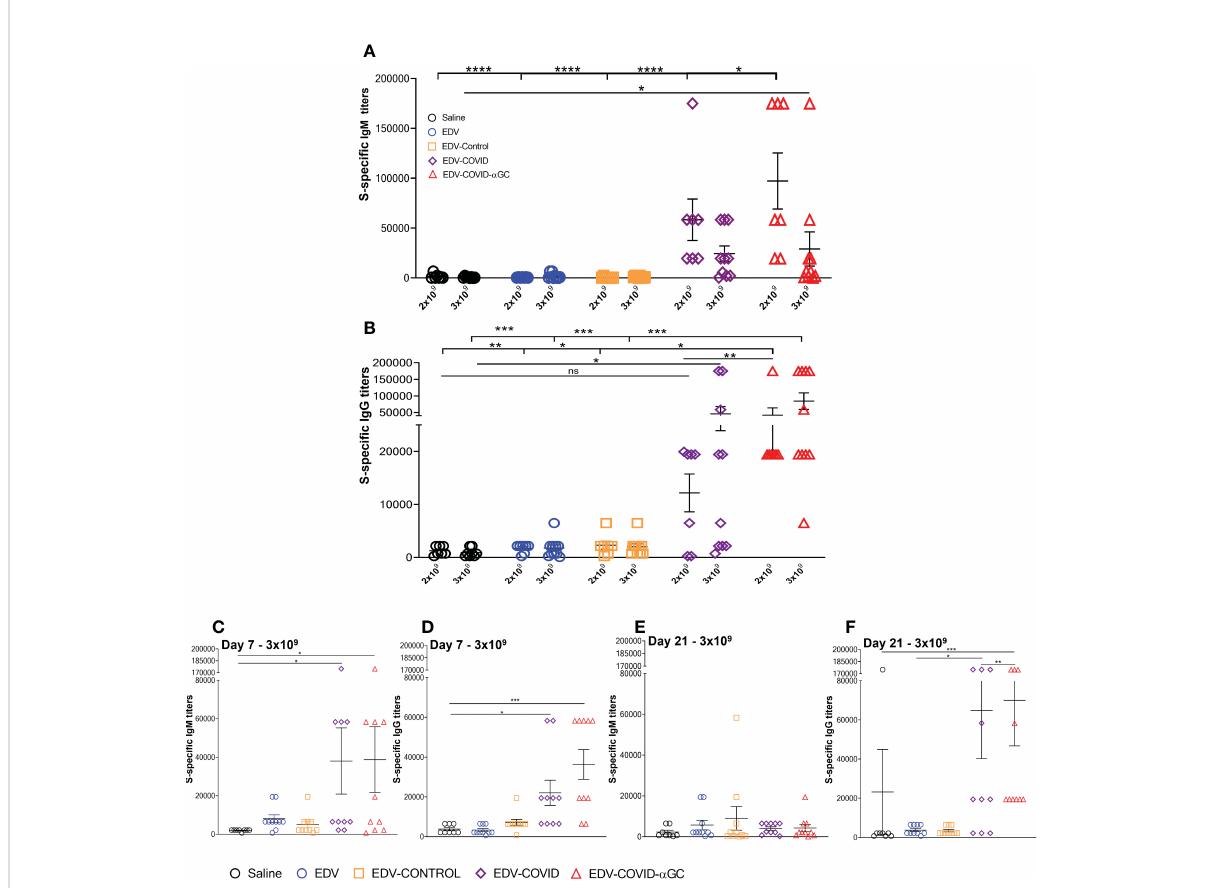
FIGURE 2 S-speci fi c IgM and IgG titers in female Balb/c mice treated with EDV-COVID- a GC on day 1 and boosted on day 21. (A) Day 28 IgM S-protein speci fi c titers for 2 x 10 9 (n = 7) and 3 x 10 9 dose (n = 10) levels. (B) Day 28 IgG S-protein speci fi c titers for 2 x 10 9 (n = 7) and 3 x 10 9 (n = 10) dose levels. (C – F) IgM and IgG S-protein speci fi c titers for 3 x 10 9 (n = 10) dose at day 7 (C, D) and at day 21 (n = 10) (E, F) . Asterisks representing signi fi cant values (**** p ≤ 0.0001; *** p ≤ 0.001; ** p ≤ 0.01; * p ≤ 0.05) and numerical p values were measured using two